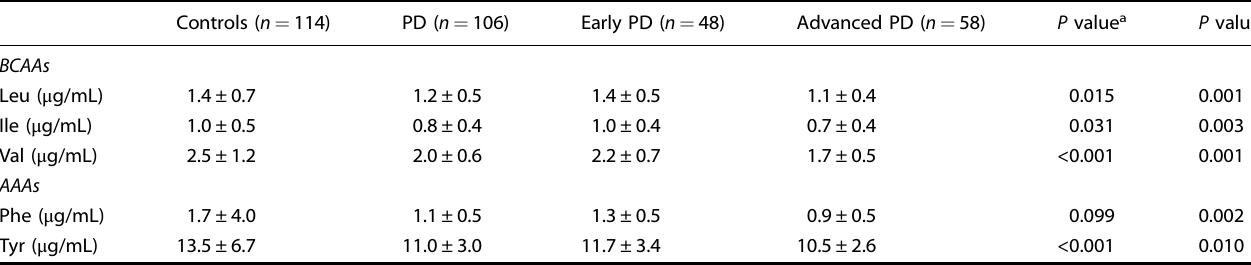
Table 2. Plasma levels of BCAAs and AAAs in controls and PD patients. Controls ( n =